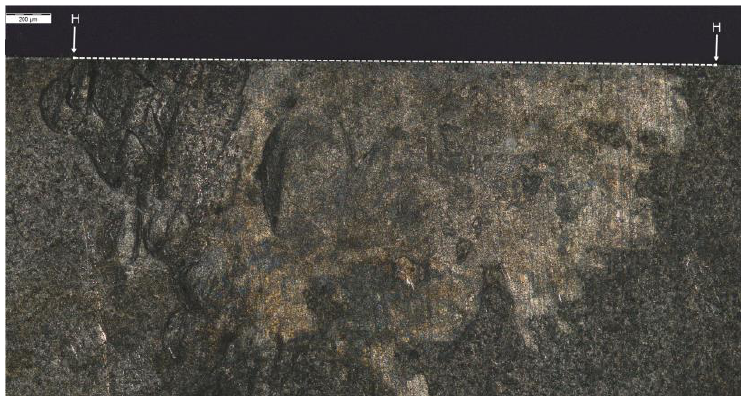
Figure 17. Microhardness measurement results. Cross-section G1-G1, zone: 3C.